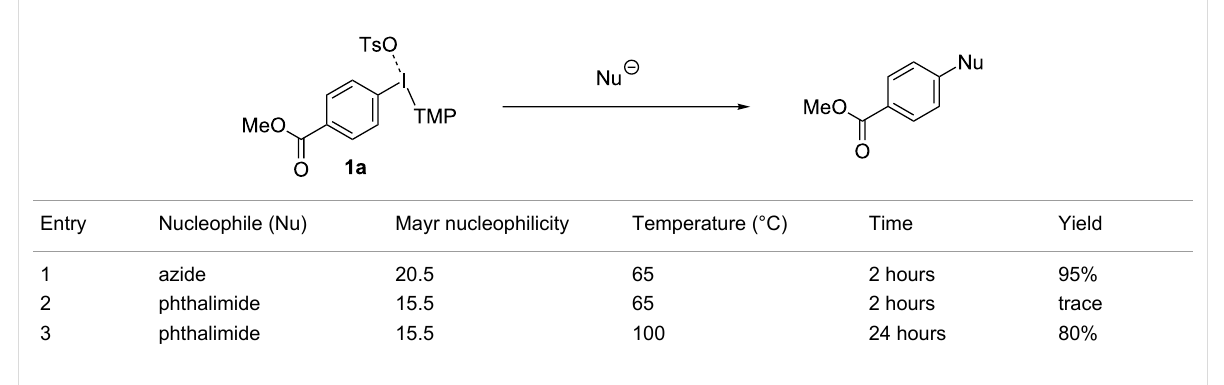
Table 2: Comparison of